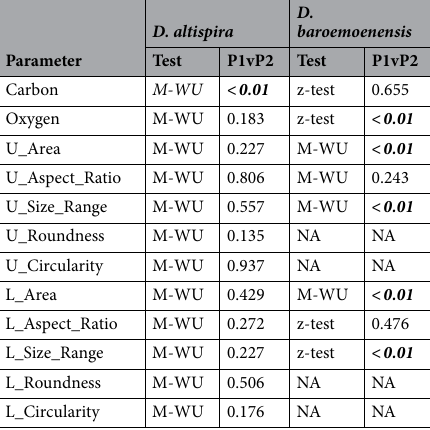
Table 2. Mann–Whitney U test results for between D. altispira and D. baroemoenen sis phase populations. Bold, italic results indicate statistical significance (p < 0.05). U, Umbilical; L, Lateral; P1, Phase 1; P2, Phase